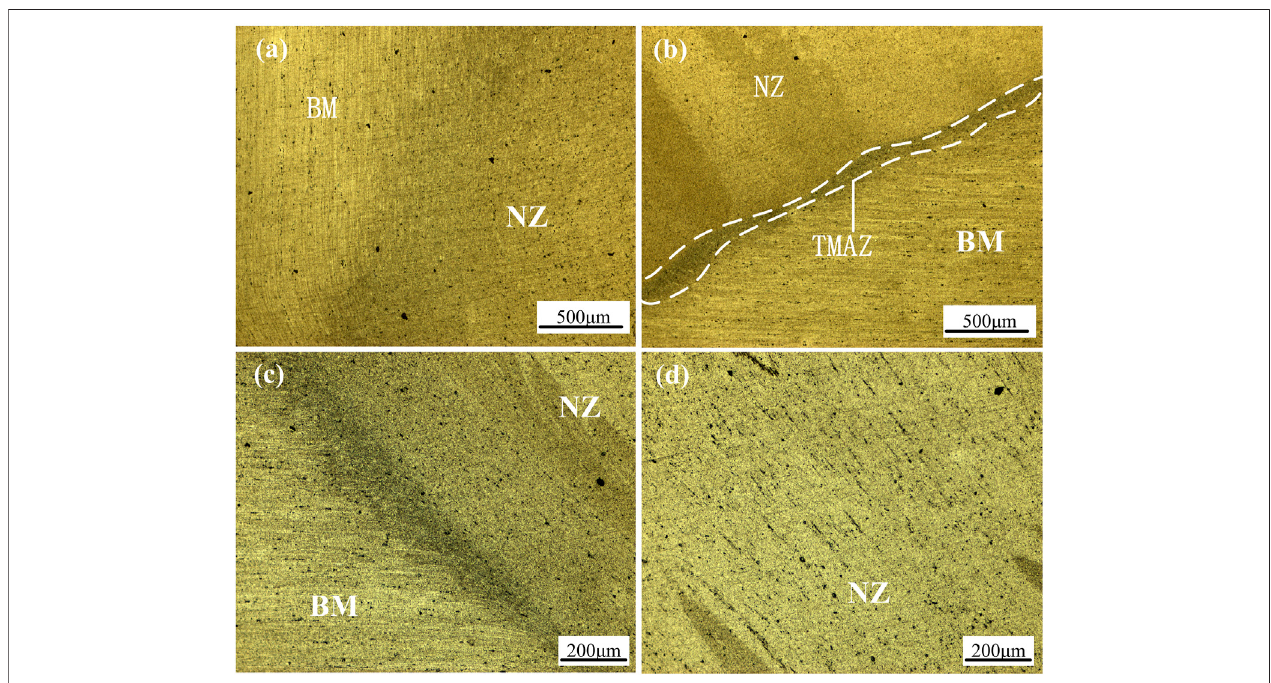
Figure 8A . Area one and Area two are the AS and RS regions, respectively. The boundary between the nugget zone (NZ) and the base metal (BM) on the AS is more noticeable than that on the